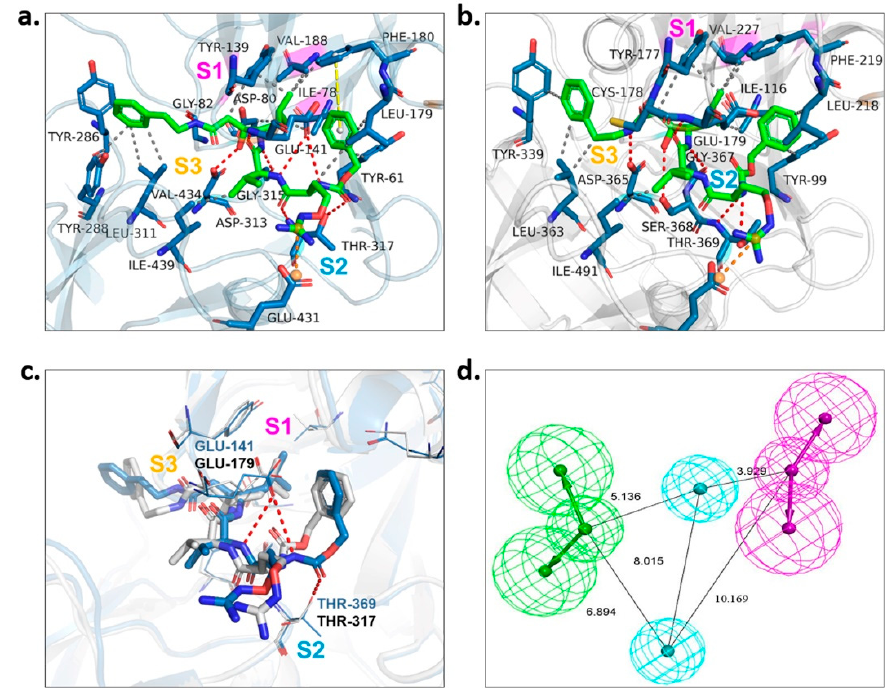
Figure 2. Pharmacophore model construction. ( a ) Protein–ligand interactions of WEHI-842 with Pv PMV. S1, S2 and S3 represent three subpockets. WEHI-842 is colored green. Dashed line in red indicates H-bond interactions, grey represents hydrophobic interaction, yellow illustrates pi–pi interaction, and orange implies salt bridge interaction. ( b ) Protein–ligand interactions of WEHI-842 with Pf PMV (M09). ( c ) Superposition of Pf PMV (in grey) and Pv PMV (in light blue) interacted with WEHI-842. ( d ) The pharmacophore model of Pf PMV.